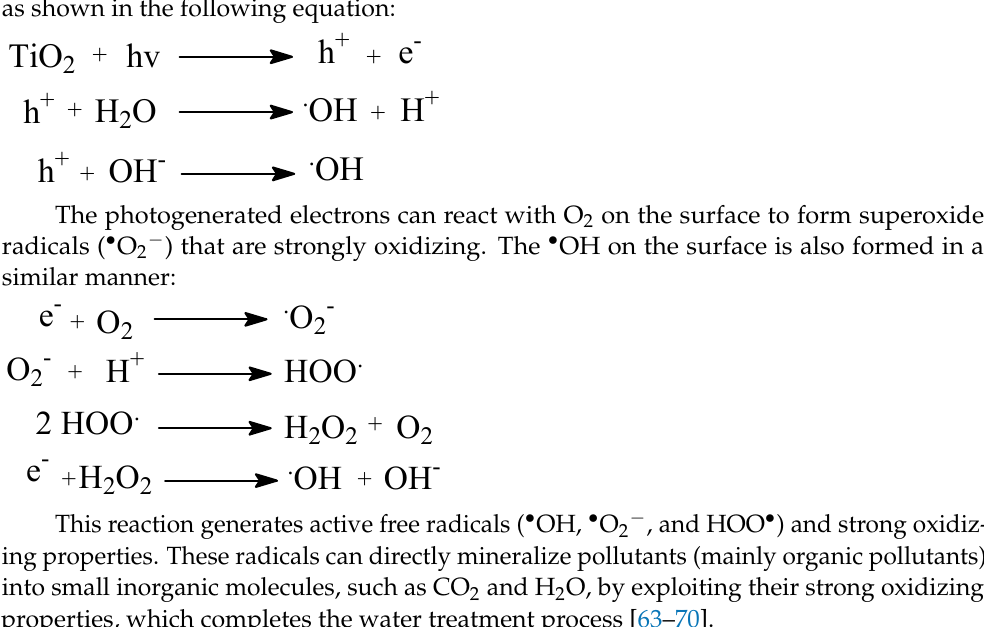
4 of 39 Figure 2. Proposed mechanism for a photocatalytic reaction on a semiconductor photocatalyst. Reprinted/adapted with permission from Ref. [42]. 2014, ACS publications As TiO 2 is a good semiconductor photocatalyst, its photocatalytic advantages, deficiencies, and preparation methods have been reviewed on many occasions [13,44–58].